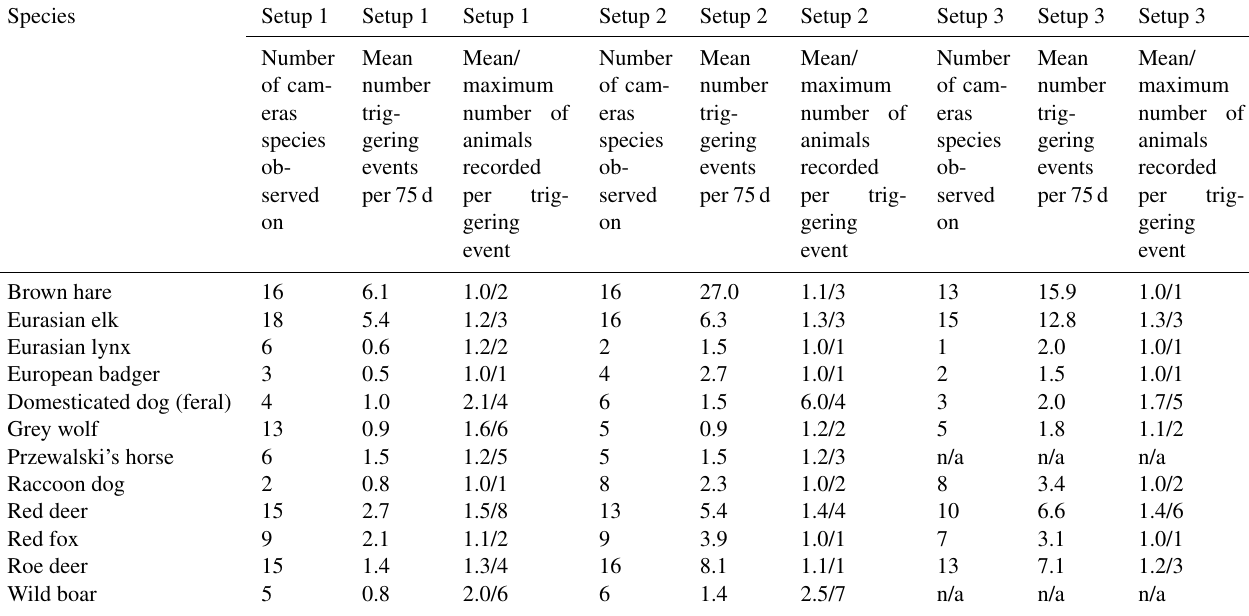
Table 2. Summary of medium and large mammal observations by setup.